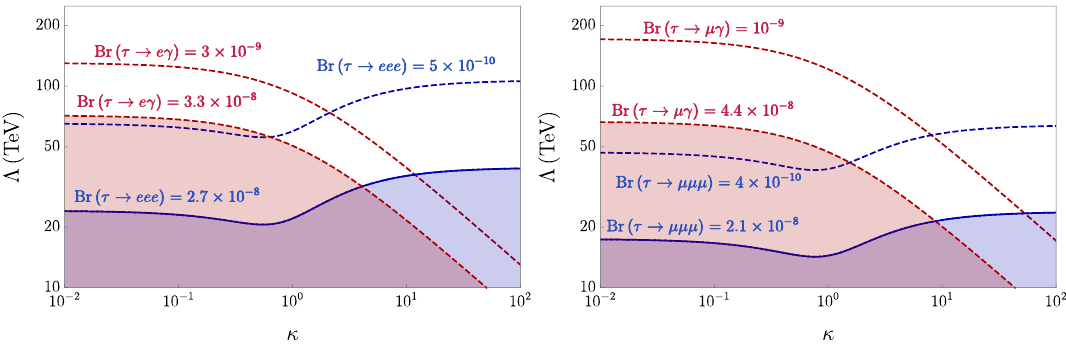
Figure 10 . Contours of BR ( τ → eγ ) and BR ( τ → eee ) , on the left, and BR ( τ → µγ ) and BR ( τ → µµµ ) , on the right, in the κ - Λ plane. The lowest values correspond to the expected future sensitivities of the Belle II experiment [6], while colored regions are excluded due to the current bounds BR ( τ → eγ ) < 3 . 3 · 10 − 8 , BR ( τ → µγ ) < 4 . 4 · 10 − 8 , BR ( τ → eee ) < 2 . 7 · 10 − 8 and BR ( τ → µµµ ) < 2 . 1 · 10 − 8 [73]. These results have been obtained with the effective Lagrangian